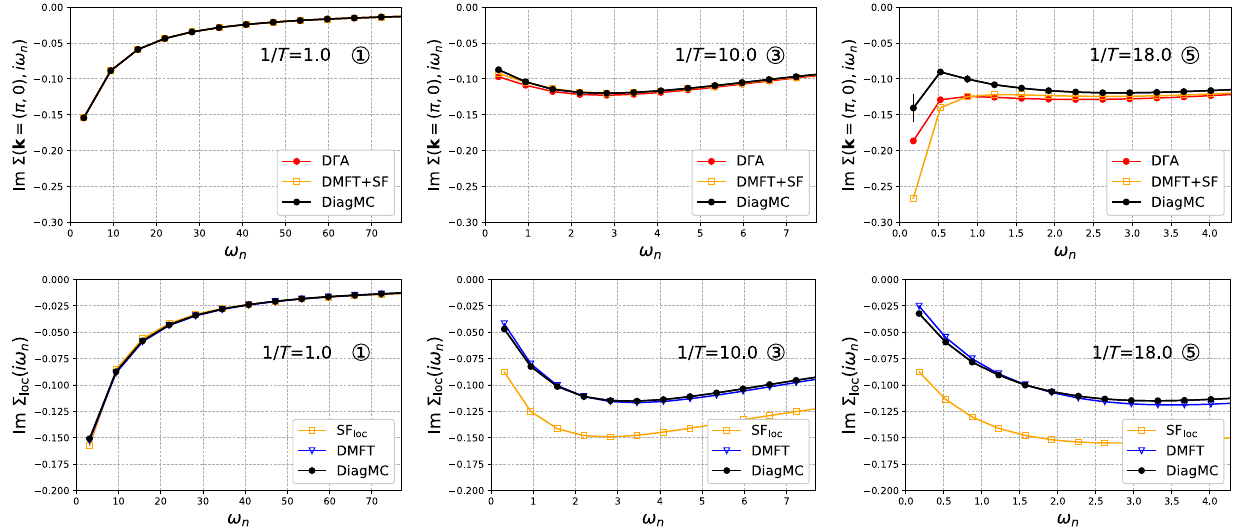
FIG. 24. Upper row: weak-coupling spin-fluctuation theory combined with DMFT according to Eq. (33) — a simplified version of D Γ A ignoring vertex corrections (see text) and comparison to the DiagMC benchmark (black circles). Lower row: comparison between the local self-energy as obtained from DMFT and the corresponding weak-coupling spin-fluctuation approximation to the DiagMC benchmark (black